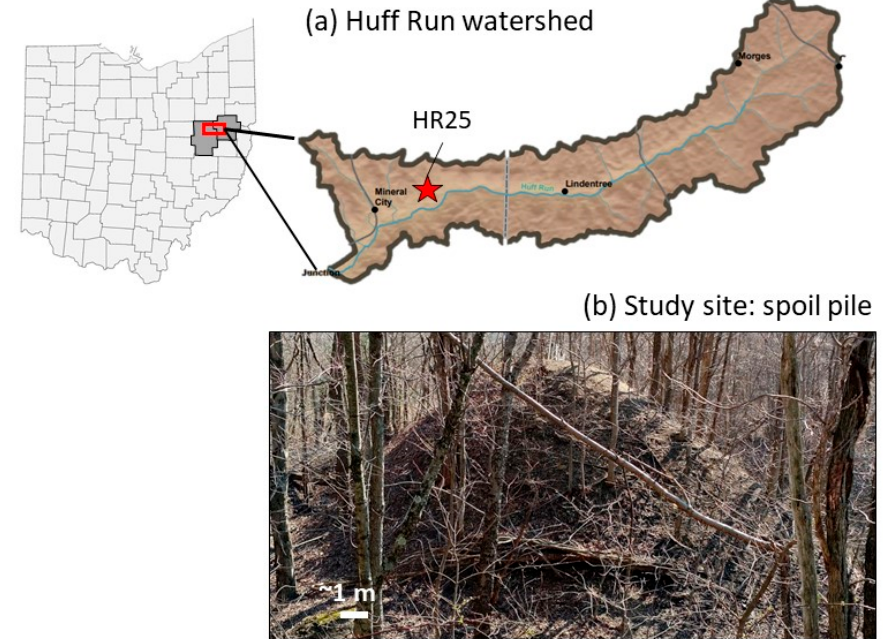
Figure 1. ( a ) A red star indicates the position of sub-watershed HR25 within the Huff Run watershed (black outline) in Ohio (base image from watersheddata.com); ( b ) Photograph of the vegetated spoil pile examined in this study that was taken during winter dormancy.